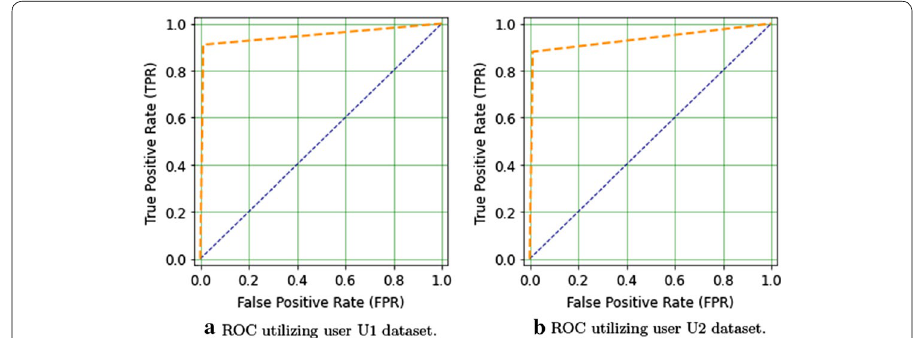
Fig. 7 Prediction results in terms of ROC values of feature extraction based random forest context-aware model considering weighted average of activity